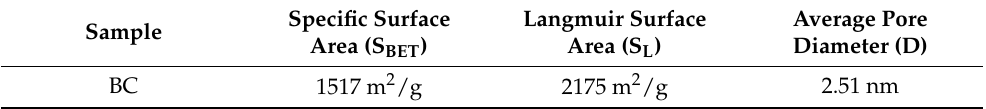
Figure 4. Isotherm linear plots and size distribution analysis of BC at STP. Table 2. SAP parameters of BC.